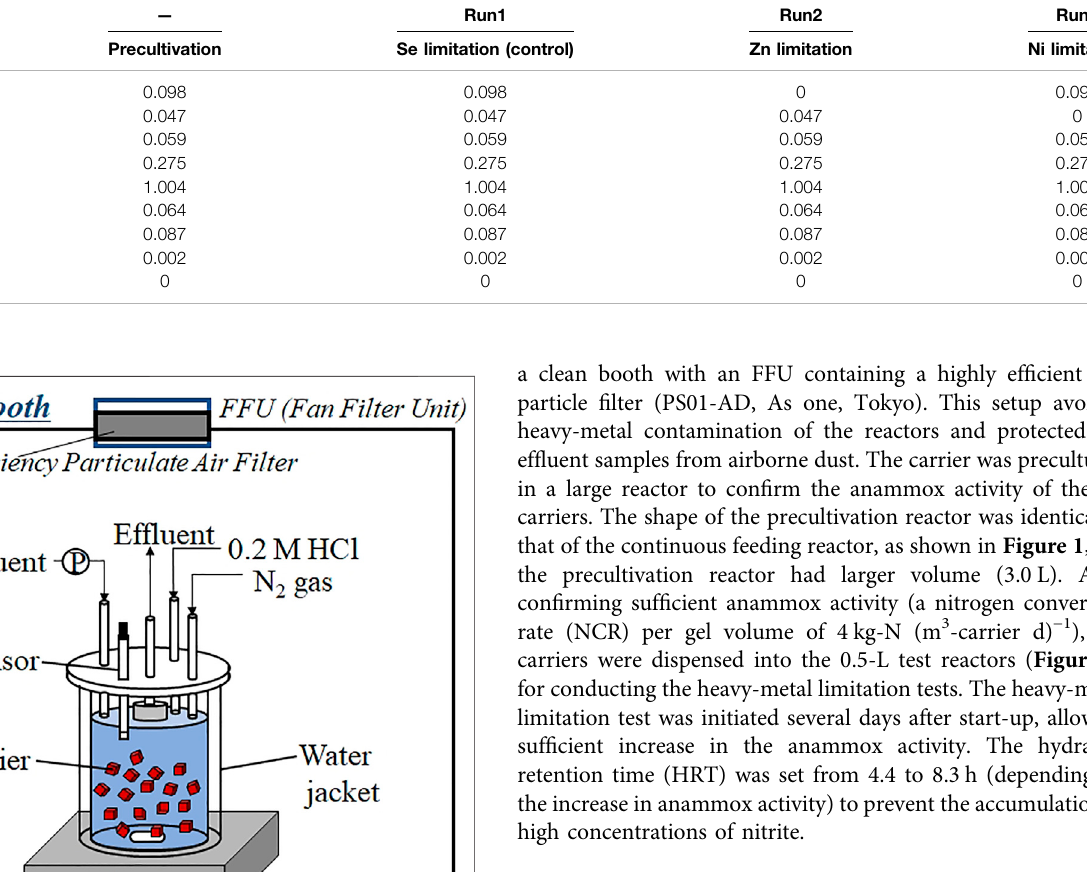
TABLE 1 | Heavy-metal concentrations in the limitation tests. Element